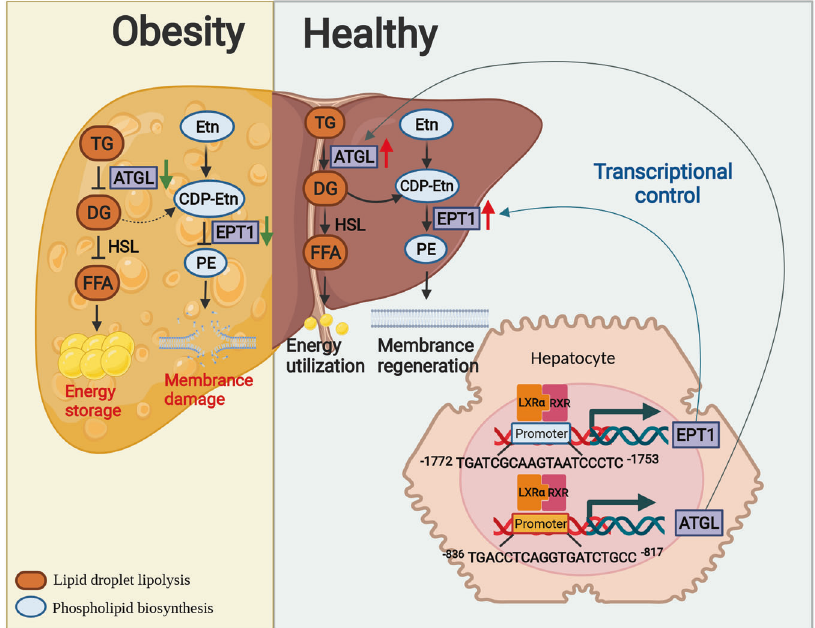
Fig. 10 Mechanism illustration. The schematic presentation depicts the proposed mechanism by which restoration of lipid homeostasis between TG and PE via the LXR α -ATGL/EPT1 axis ameliorates obesity and related